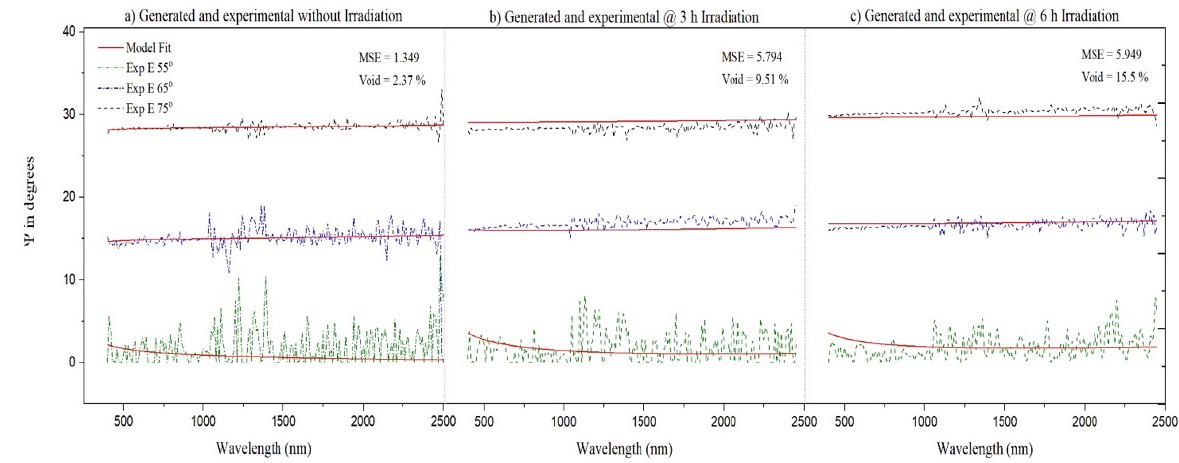
Figure 7. Spectroscopic ellipsometric Ψ for the SiO 2 sample before and after 3 h and 6 h irradiation at incidence angles of 55°, 65°, and 75°.